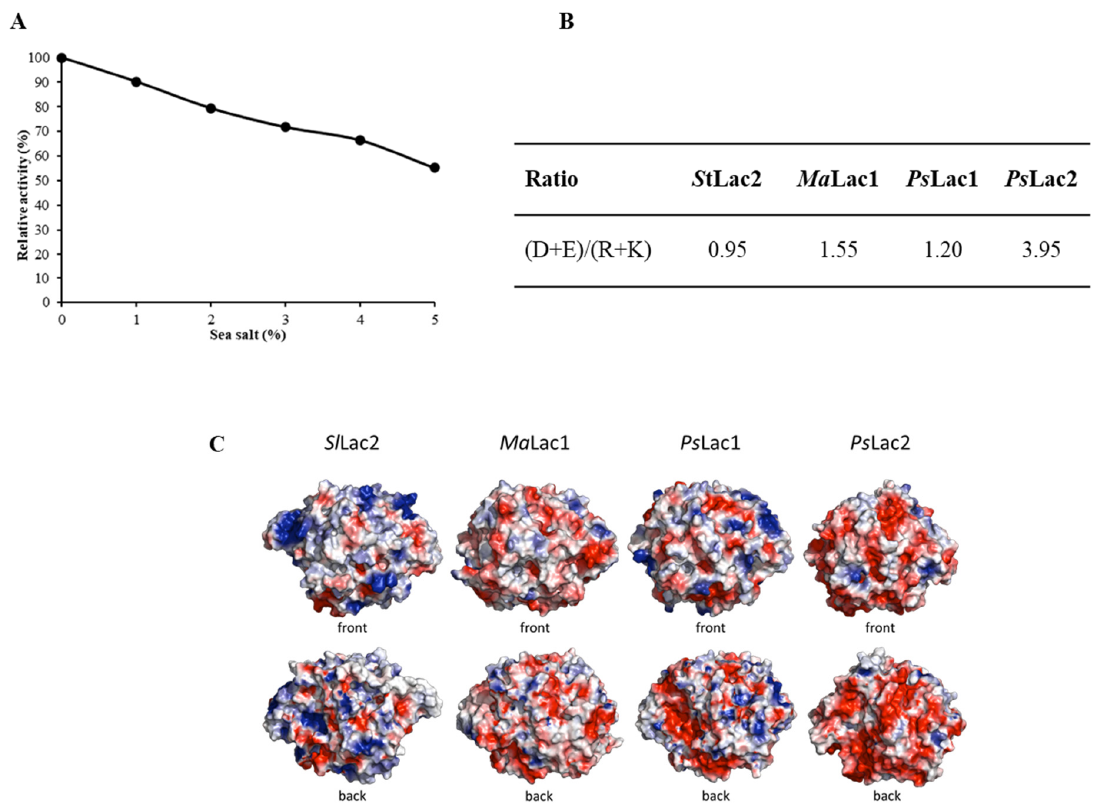
Figure 4. Effect of sea salt and surface charge of Sl Lac2. ( A ) Effect of different concentrations (1, 2, 3, 4 and 5% wt / vol) of sea salt on Sl Lac2 activity. ( B ) (D + E) / (R + K) amino acids ratio of Sl Lac2 compared with those from Melanocarpus albomyces laccase 1, Ma Lac1 (Q70KY3) and Pestalotiopsis sp. laccases 1 and 2, Ps Lac1 (KY554800) and Ps Lac2 (KY5548001). ( C ) Surface charge plots (negative and positive charges are in red and blue, respectively) of Sl Lac2 compared with those from M. albomyces laccase 1, Ma Lac1 and Pestalotiopsis sp. laccases 1 and 2, Ps Lac1 and Ps Lac2. The surface potentials were calculated using the vacuum electrostatics function of the PyMOL molecular graphics system (Schrödinger, New York, NY, USA).